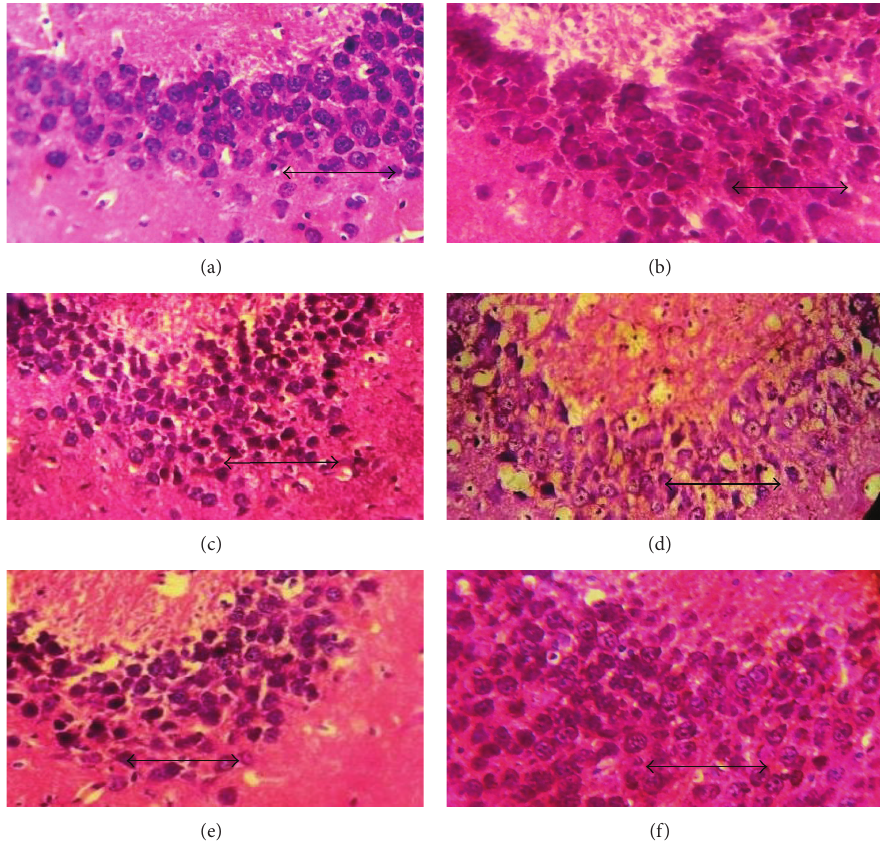
Figure 3: Effect of lisinopril and fosinopril on the morphology of CA3 region of hippocampus in scopolamine-induced amnesic rats. Light photomicrographs of CA3 layer of hippocampus in (a) control rats, (b) scopolamine, (c) lisinopril (0.225 mg/kg) + scop., (d) lisinopril (0.45 mg/kg) + scop., (e) fosinopril (0.90 mg/kg) + scop., and (f) fosinopril (1.80 mg/kg) + scop. Scale bar represents 1 𝜇